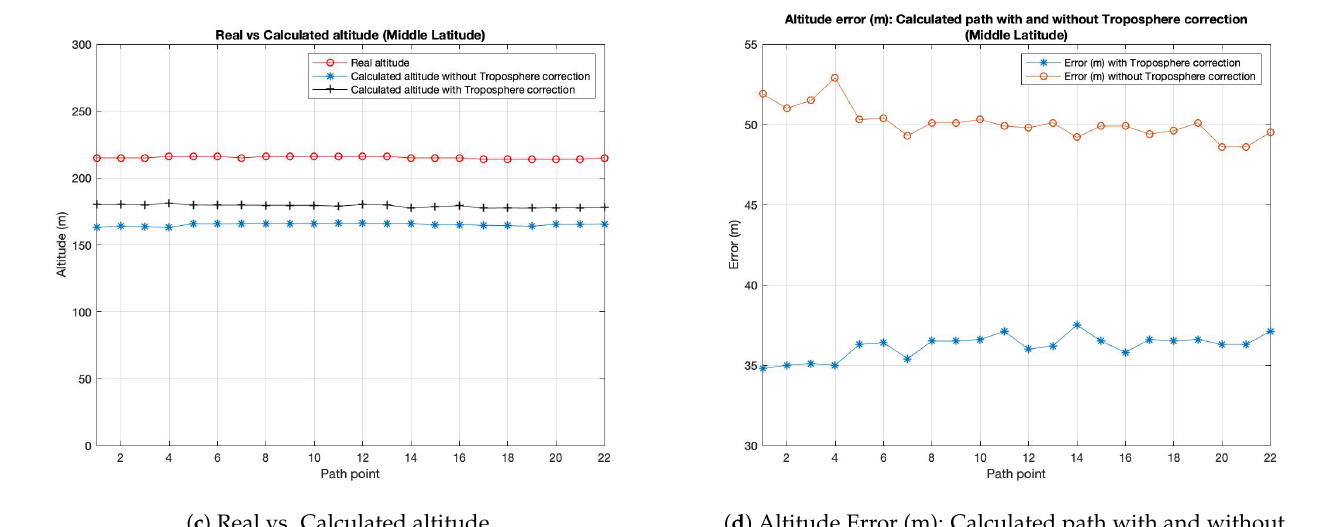
Figure 7. Experimental results for Middle Latitude (route in